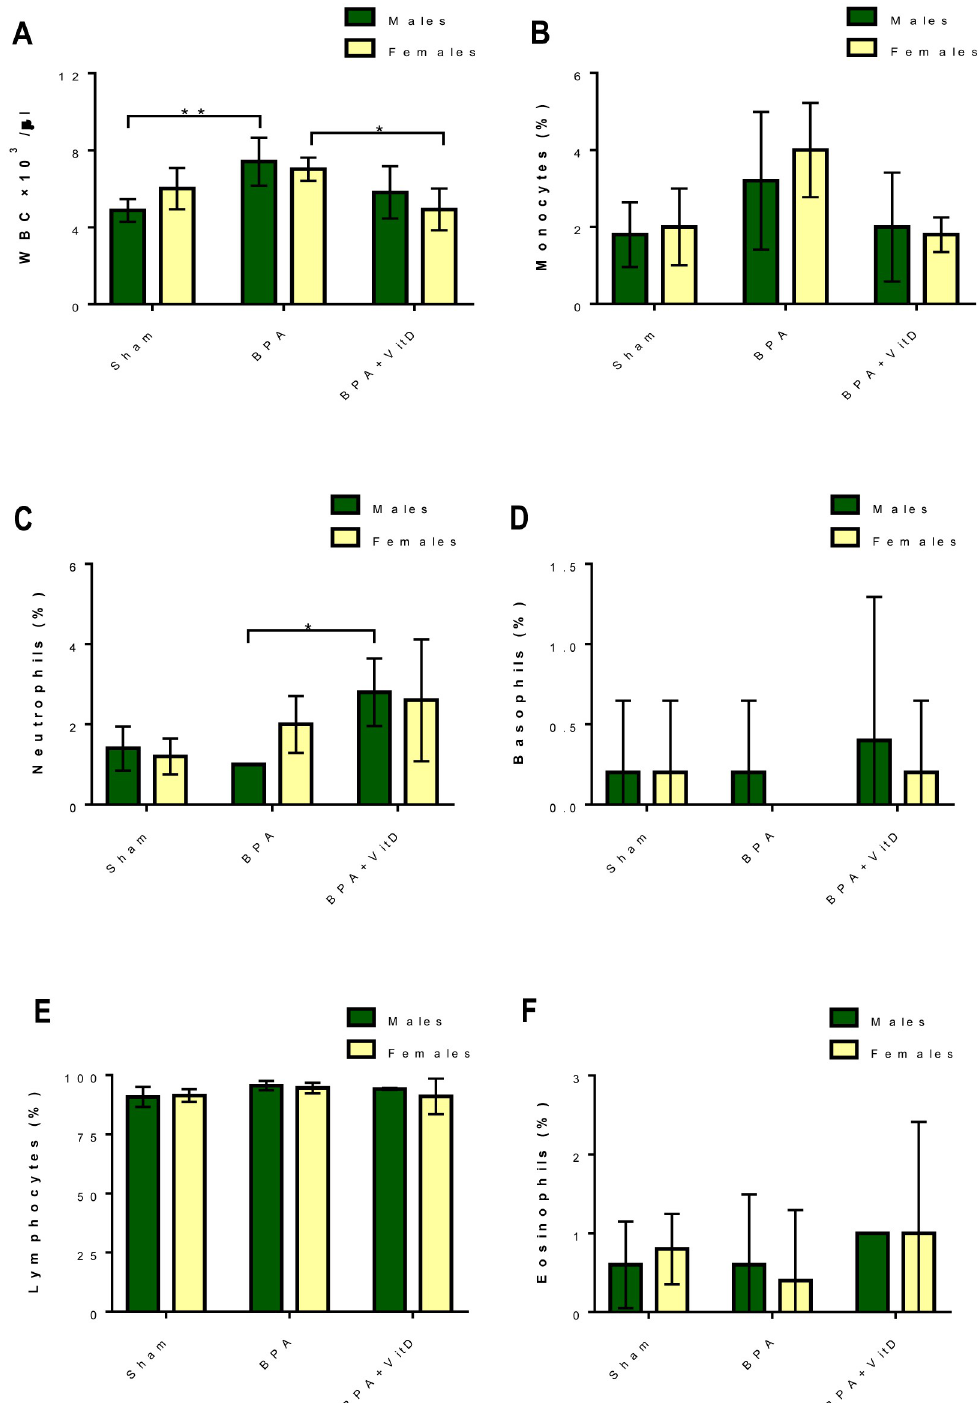
Fig 4. VitD attenuates leukocyte counts following BPA exposure. The mice were divided into different groups: control, vehicle, VitD, BPA, or BPA+VitD. The quantification of (A) WBCs, (B) monocytes, (C) neutrophils, (D), basophils, (E) lymphocytes, and (F) eosinophils. Data are represented as mean ± SD (n = 12), P < 0.05 is represented as � , and P < 0.01 is represented as �� .